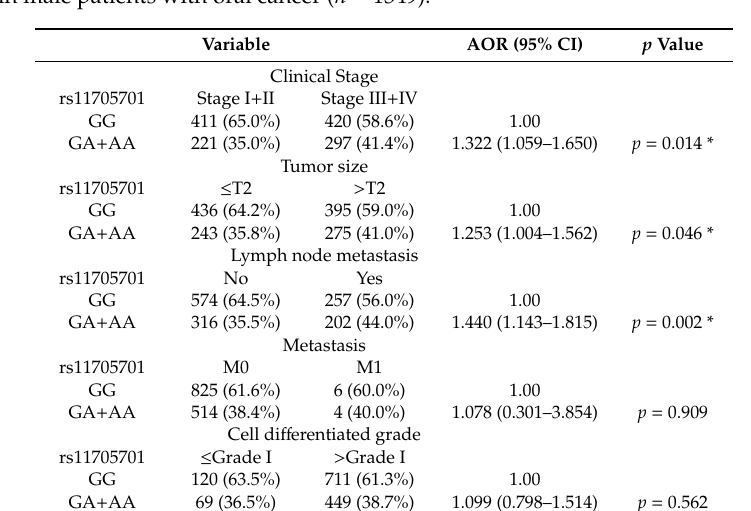
Table 3. Odds ratios and 95% CIs of clinical status associated with genotypic frequencies of IGF2BP2 rs11705701 in male patients with oral cancer ( n =